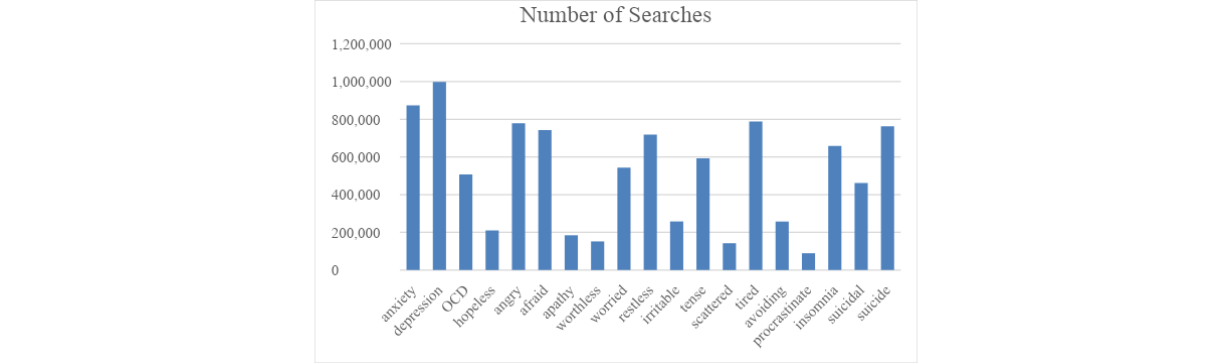
Figure 2. This plot depicts the estimated total volume of searches between March 18-23, 2020, for each search term. OCD: obsessive-compulsive